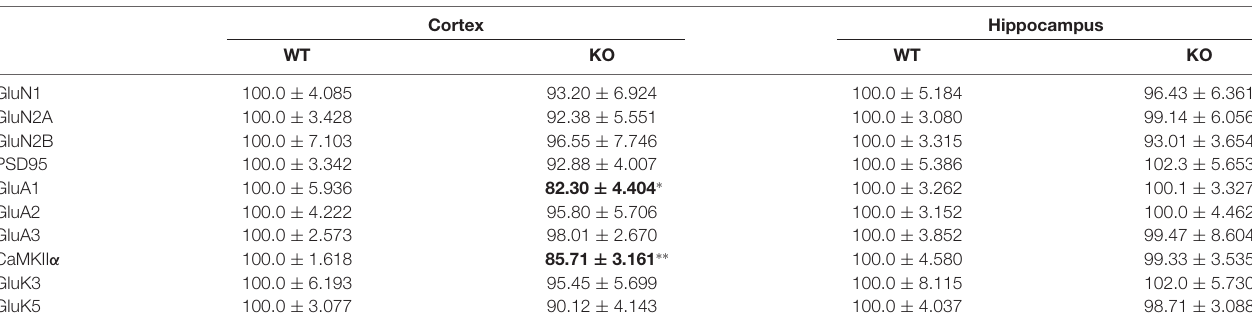
TABLE 1 | Quantification of synaptic protein